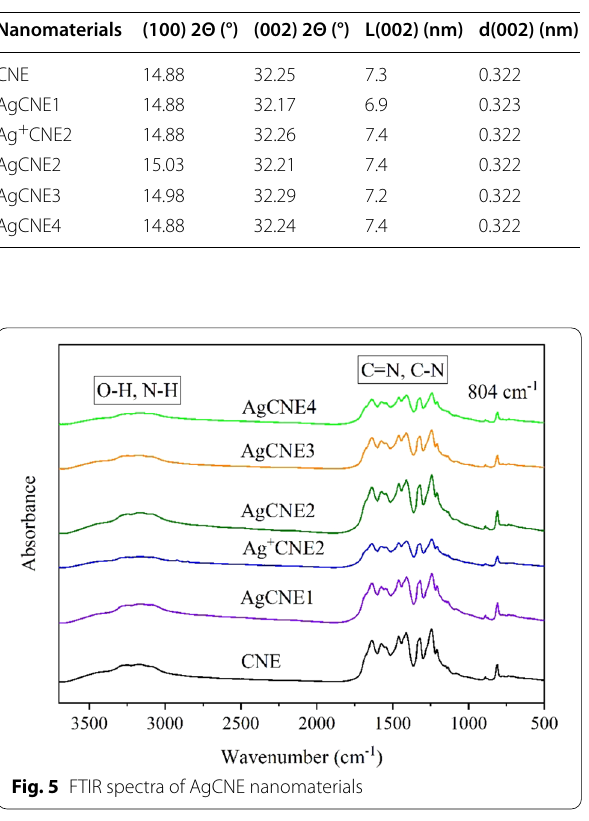
Fig. 5 FTIR spectra of AgCNE nanomaterials